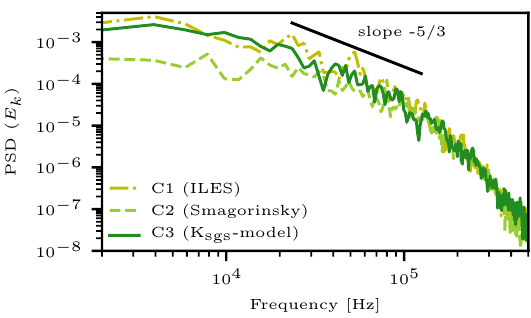
Figure 14. Power spectral density of the kinetic energy. Velocity probe is located at distance 67 d n away from the nozzle and 11 d n off the spray centerline. Signal is recorded for 2 ms simulation time with sampling frequency of 10 6 Hz. PSD is computed based on Welch